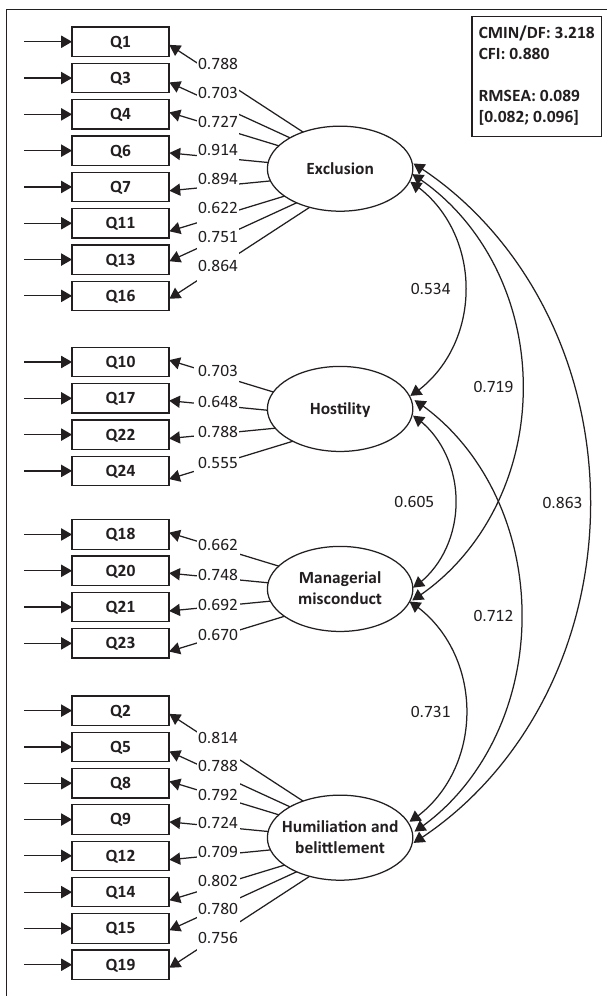
FIGURE 1: Confirmatory factor analysis results for the four-factor workplace bullying model with standardised regression weights and correlations.